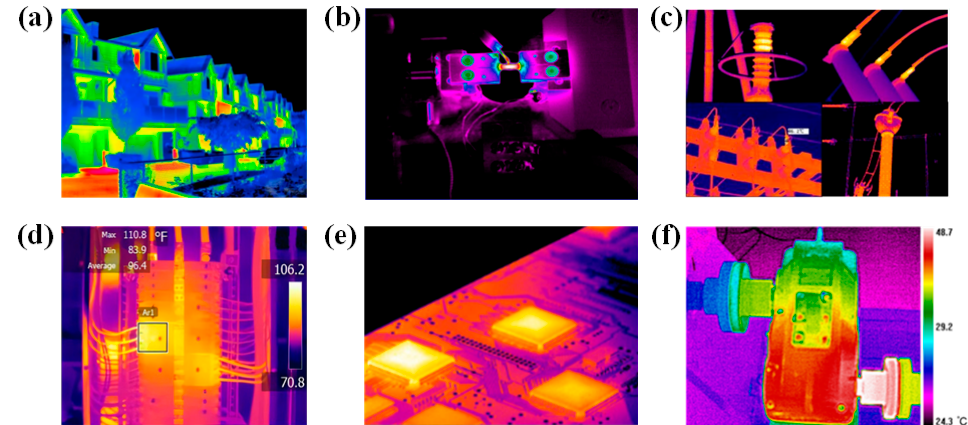
Figure 1. Some applications of infrared thermography technology: ( a ) Inspection of exterior structure. ( b ) Material fatigue damage assessment ( c ) Health status monitoring of the electrical equipment. ( d ) Inspection of corroded parts of oil refining equipment ( e ) Defect detection of circuit board. ( f ) Fault diagnosis of the mechanical equipment.